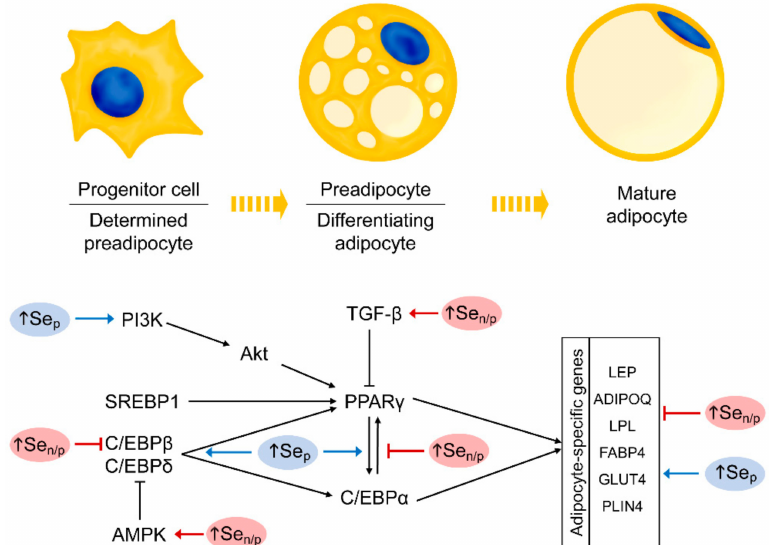
Figure 3. Di ff erential e ff ects of physiological (blue, Se p ) and supraphysiological (red, Se n / p ) doses of selenium on adipocyte di ff erentiation mechanisms in vitro. Briefly, selenium in the physiological range possesses overall adipogenic e ff ect by activation of PPAR and C / EBP α signaling through positive modulation of PI3K / Akt and C / EBP β / δ pathways, resulting in up-regulation of adipocyte-specific genes. Oppositely, Se overload exerts antiadipogenic activity through suppression of PPAR and C / EBP α expression though several mechanisms including reduction of C / EBP β expression as well as activation of AMPK and TGF- β . ADIPOQ, adiponectin; Akt, protein kinase B; AMPK, 5 (cid:48) AMP-activated protein kinase; C / EBP, CCAAT-enhancer binding protein; FABP4, fatty acid binding protein 4; GLUT4, glucose transporter type 4; LEP, leptin; LPL, lipoprotein lipase; PI3K, phosphatidylinositol-3-kinase; PLIN4, perilipin 4; PPAR, peroxisome proliferator-activated receptor; SREBP1, sterol regulatory element-binding protein 1; TGF- β , transforming growth factor β